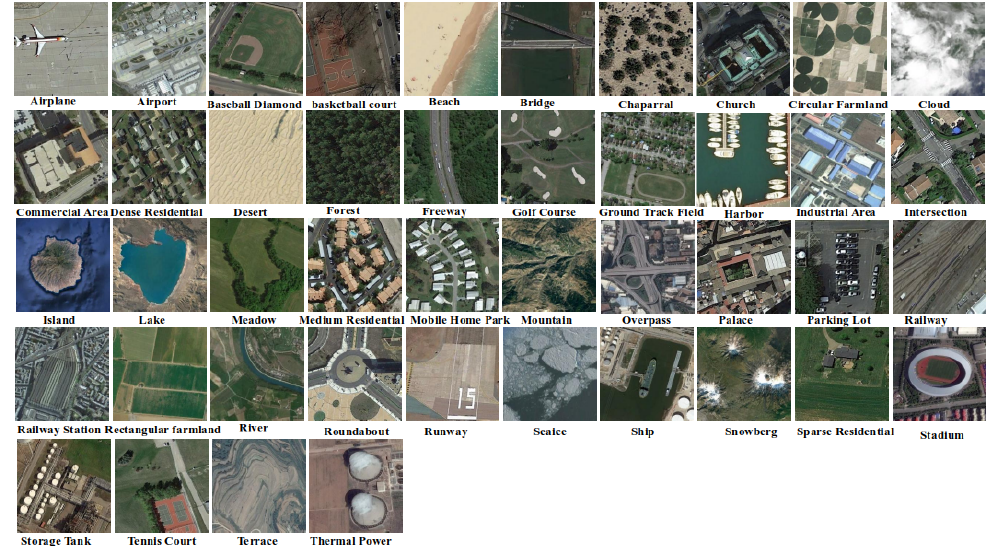
Figure 4. Example images associated with 45 land use categories in the NWPU RESISC45 data set.